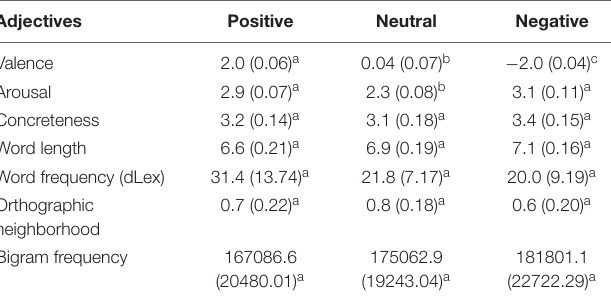
TABLE 3 | Means for the set of German word attributes are given with standard deviations in parentheses; valence and arousal values are derived from the Berlin Affective Word List revised (BAWL-R; Võ et al., 2009) BAWL-R values range from − 3.5 to + 3.5; lexicographic values come from dlex (Heister et al., 2011); means sharing the same superscript do not differ statistically.